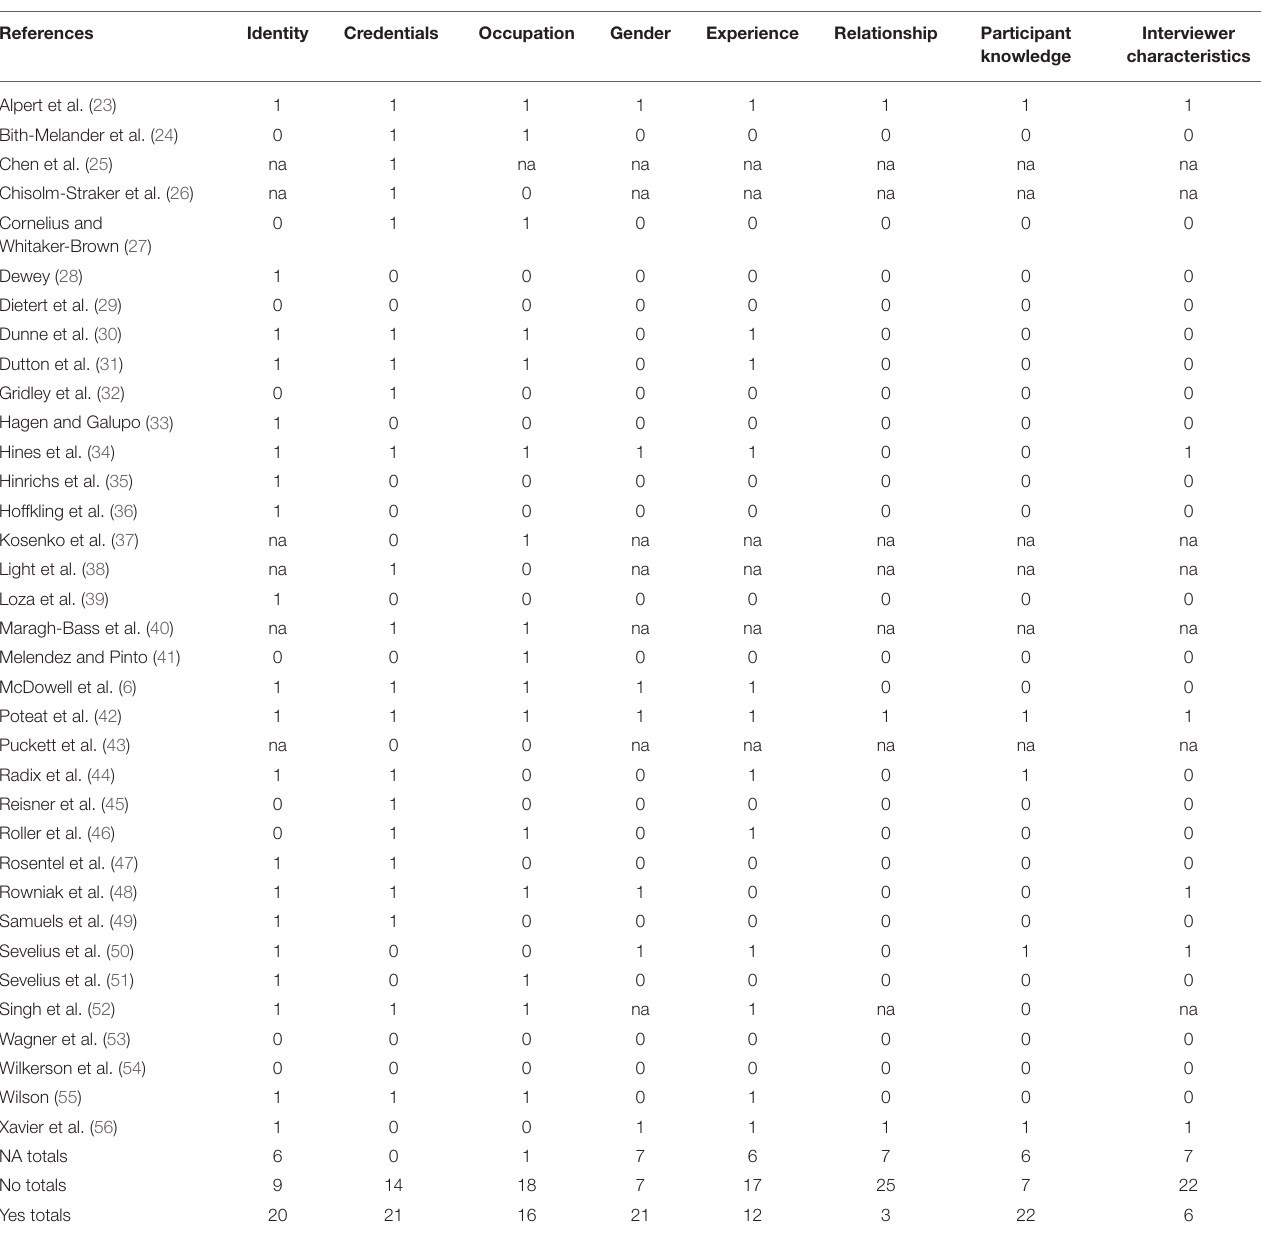
TABLE 4 | COREQ domain 1: research team and